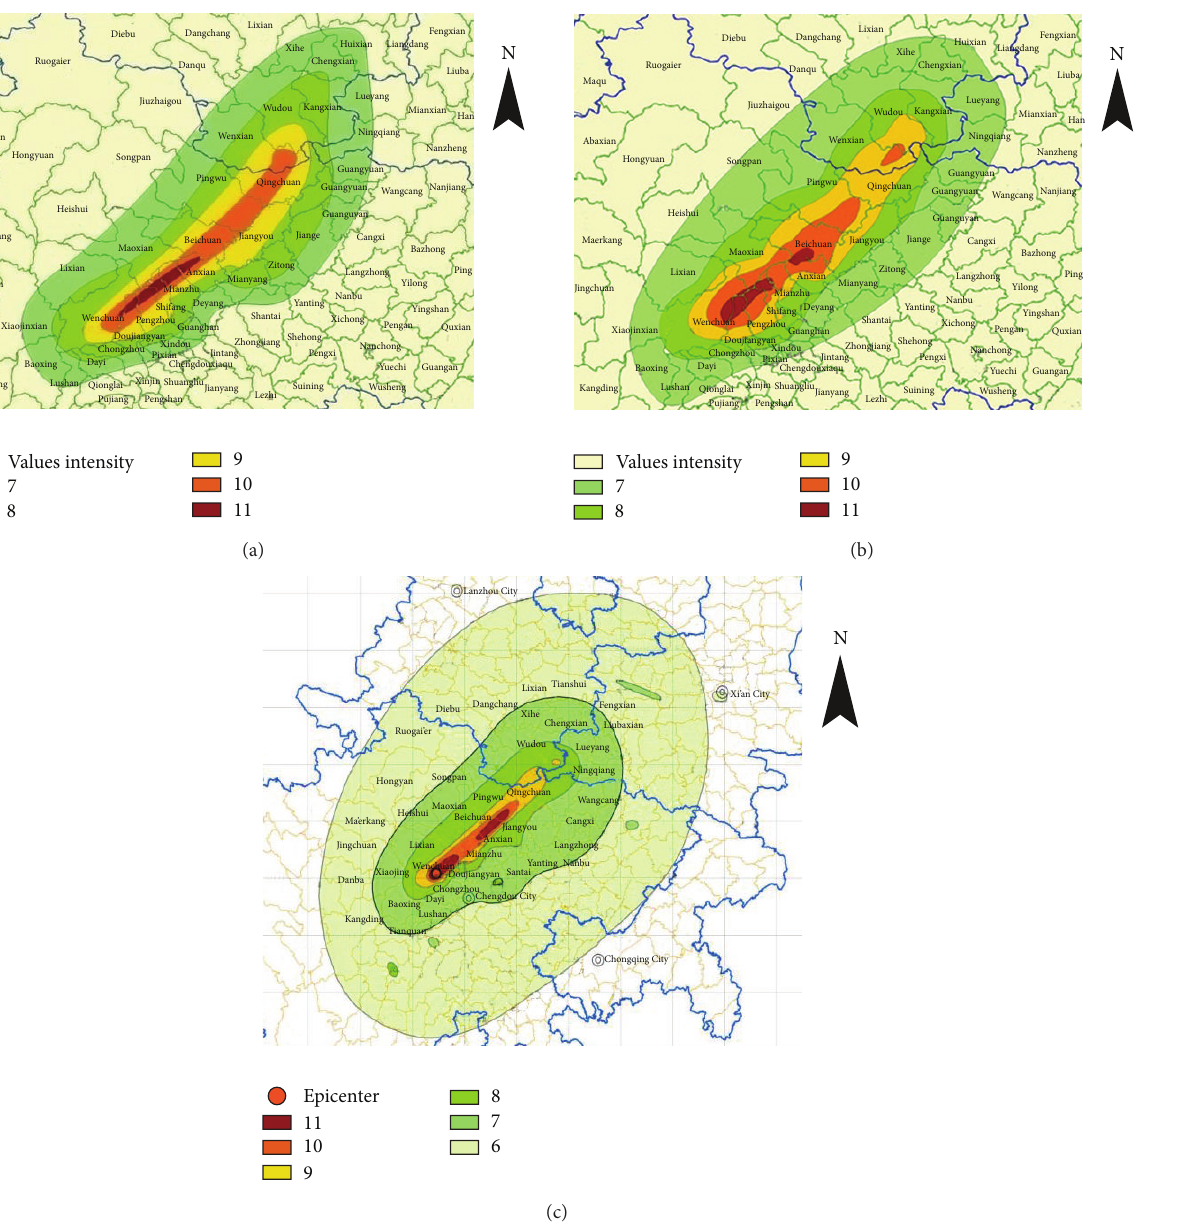
Figure 6: (a) Intensity map based on fifteen evaluation areas; (b) intensity map based on forty evaluation areas; (c) intensity map based on field investigation (published by Seismological Administration of